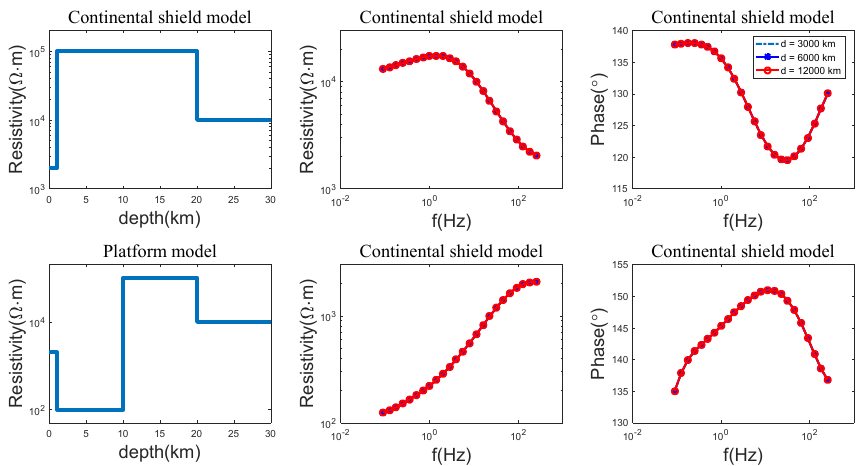
(cid:12) (cid:12) 2 , (cid:12) E θ / H ϕ (cid:12) ωµ